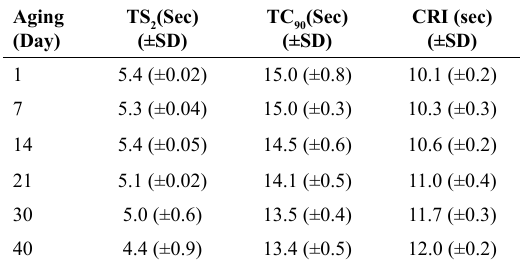
Table 2. Rheological properties of BR/SBR blends aged for different